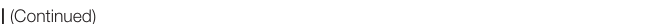
FIGURE 3 | (Continued) appearance of P21 mice. White arrows indicate shortened forelimbs in CKO (right) mice compared to control (left) mice. (D) Representative three-dimensional micro-computed tomography (micro-CT) images of trabecular bony architecture and cortical bone thickness of distal femur harvested from P21 control and CKO mice. (E) Representative three-dimensional micro-CT images of humerus harvested from P21 control and CKO mice. (F) Body weight and humerus length of CKO mice were quantified ( n = 6, mean ± standard deviation). (G) qRT-PCR analysis revealed abruptions of Lrp5 gene expression in bone and skeletal tissues harvested from P0 CKO mice. (H) Quantified micro-CT data. Data are shown as mean ± standard deviation ( n = 6). (I) Gross appearance of dissected mesenteric and gonadal fat from 2-month-old control and CKO mice. White arrows indicate an increase in the volume of gonadal fat in CKO mice. (J) Quantification on mesenteric and gonadal fat pad mass as a percentage of body weight in 2-month-old control and CKO mice. The mesenteric and gonadal fat were significantly increased in CKO mice ( n = 6, mean ± standard deviation). (K) qRT-PCR analysis on bone marrow mesenchymal stromal cells (BMSCs) harvested from mouse forelimbs indicated a significant decrease in mRNA expression levels of lipid metabolism genes, including Acadl , Acat2 , Acsl1 , Cpt1b , and Hadha , as well as Lrp5 , * p < 0.05, ** p < 0.01, and *** p <